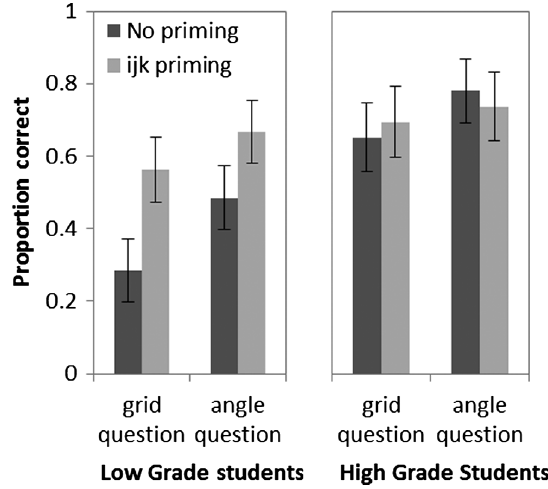
FIG. 10. Student performance ( N ¼ 221 ) on arrow-angle and arrow-grid formats (Fig. 6) with and without first answering a similar ijk -format question ( “ ijk priming ” ) for low course grade and high course grade students. Error bars indicate (cid:2) 1 SE.